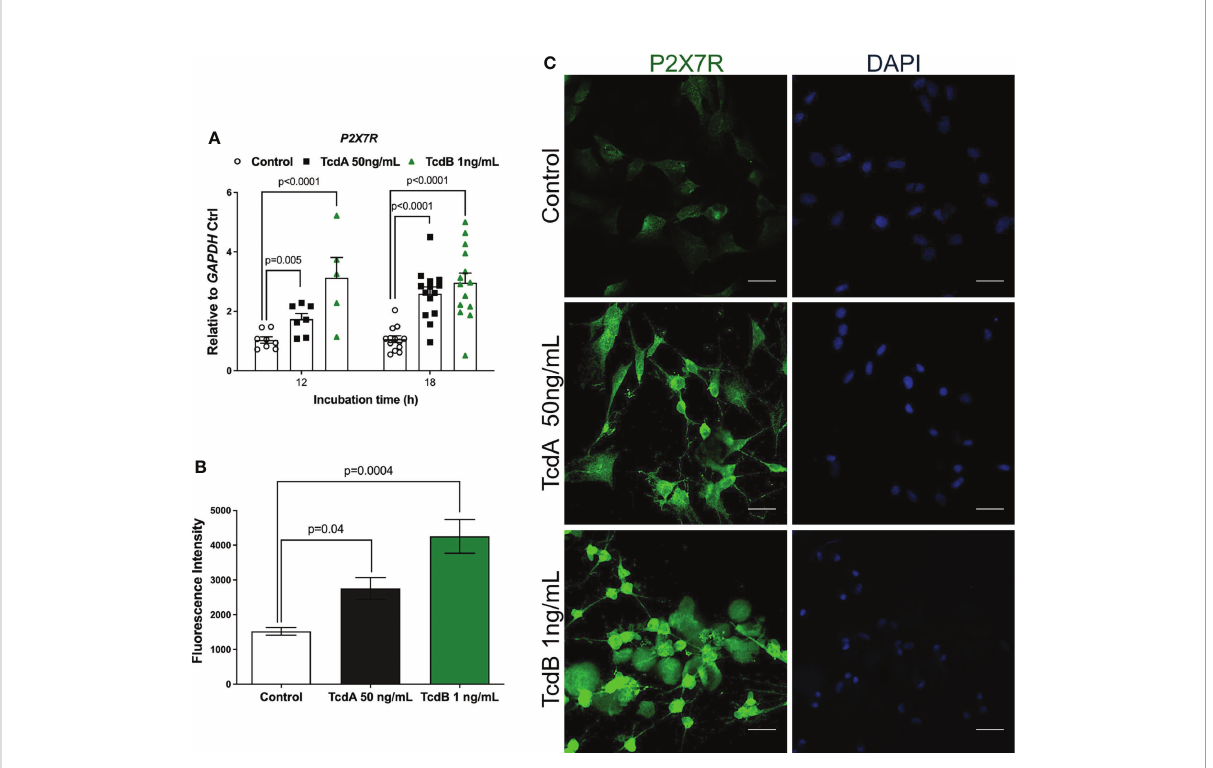
FIGURE 4 TcdA and TcdB upregulate P2X7R expression in EGCs. (A) Gene expression of P2X7R were evaluated by qPCR in EGCs incubated with DMEM only (control), TcdA (50 ng/mL) and TcdB (1 ng/mL). The data are the mean ± SEM. Two-way ANOVA followed by the Tukey test was used. (B) Fluorescence intensity of P2X7 R immunostaining in EGCs measured by ImageJ software. The data are the mean ± SEM. One-way ANOVA followed by the Tukey test was used. p value is represented in the graph (C) Representative photomicrographs of P2X7R (green) immunostaining and DAPI (blue) nuclear staining in EGCs exposed to TcdA and TcdB after 18 h of